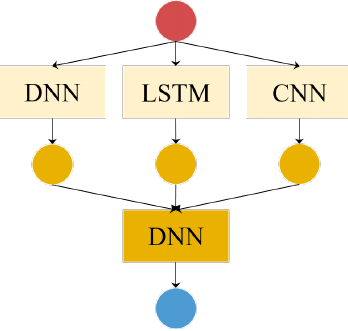
Figure 10. Stacking ensemble model: DNN, LSTM, and CNN are used as base learners at the first level and another DNN as a meta learner at the second